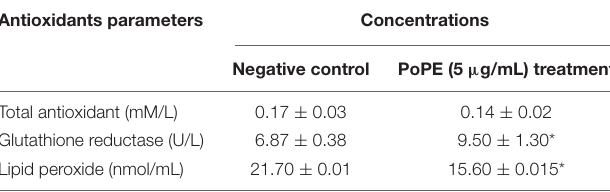
TABLE 6 | The concentration of Total antioxidant, Lipid peroxide, and Glutathione reductase in PoPE’ MCF-7 treated group with the negative control group. Antioxidants